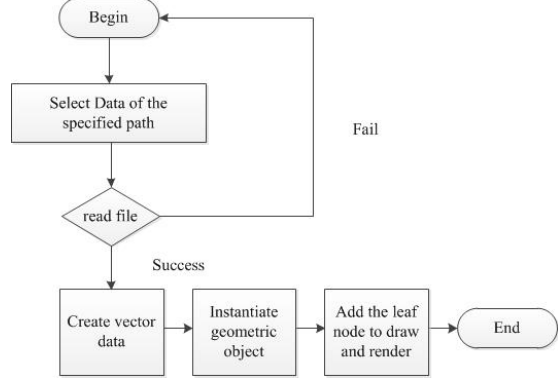
Figure 6. Step of point cloud data visualization (1) Click on the platform to select the point cloud data of the specified path.